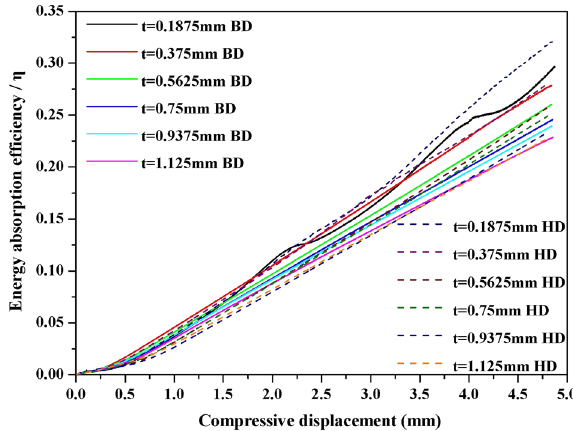
Figure 21. Energy absorption efficiency curve of Gyroid surface with different wall